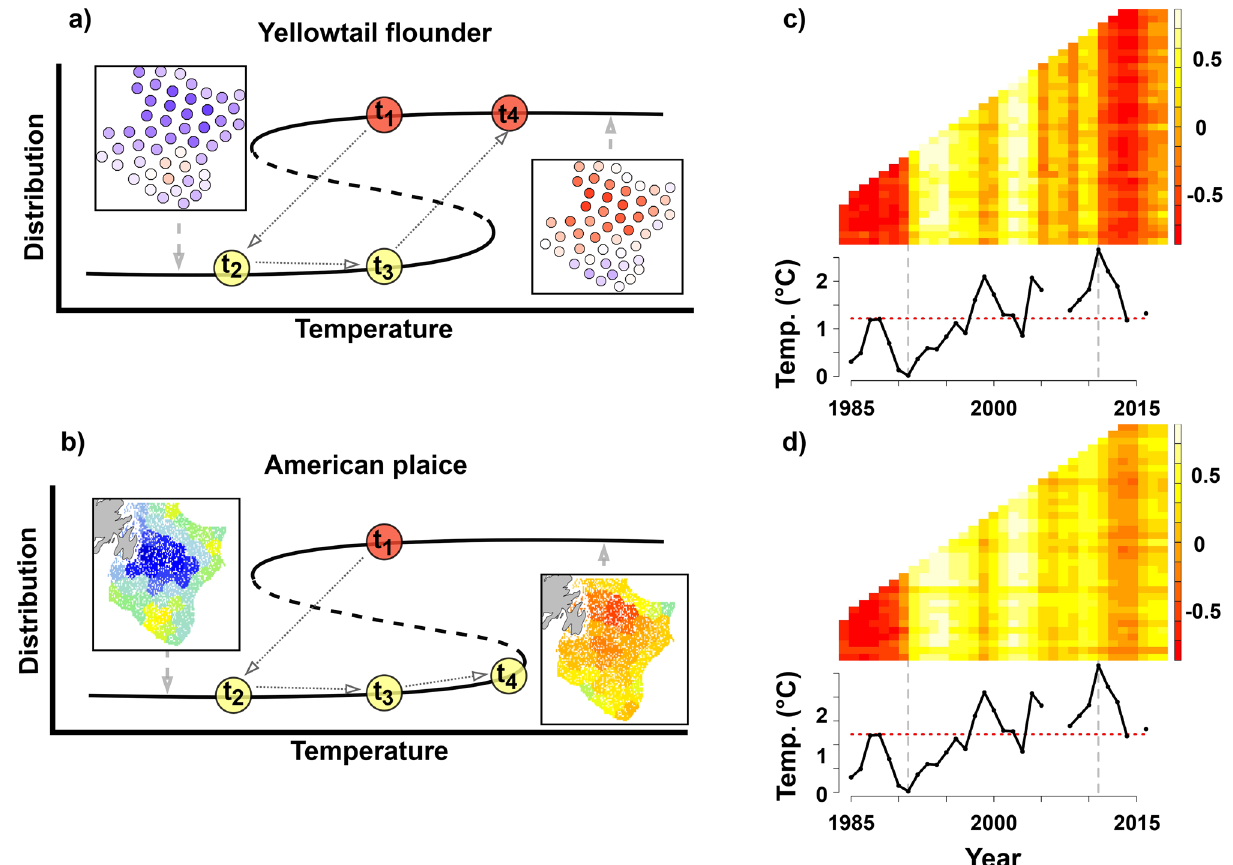
Figure 4. Diagram of spatial distribution recovery results, format based on Fig. 2. Line drawings for ( a , b ) represent the theoretical pattern that matches the observations for each species. t 1 and t 3 represent snapshots in time with equal temperature, while t 4 represents a snapshot with a higher temperature. Maps for ( a , b ) represent snapshots that define each spatial state, where the maps for ( a ) represent the residuals (blue = negative, red = positive) of the density-dependent model for yellowtail flounder (see Fig. S16) and maps for ( b ) represent the spatial distribution (blue = low density, red = high density) of American plaice from the Vector Autoregressive Spatiotemporal model [VAST] (see Fig. S8). Finally, ( c , d ) is the correlation analysis of spatial distributions (y-axis) and bottom water temperature distributions (x-axis) over time (yellow = high correlation, red = negative correlation) along with the mean annual temperature trend on the Grand Bank shown beneath the correlation plots (dashed grey lines represent the minimum [1991] and maximum [2011] mean temperatures; dotted red line represents the mean temperature over the entire time-series). High correlation in panels ( c , d ) indicates that areas with high density occur in areas with warmer temperatures and negative correlation indicates that areas with high density occur in areas with cold temperatures. Figure made using R (version 3.6.2. https:// www.r- proje ct. org/) 69 and the packages sp 71 , ggplot2 77 , VAST 78 , raster 73 , fields 79 , RColorBrewer 80 and the software diagrams